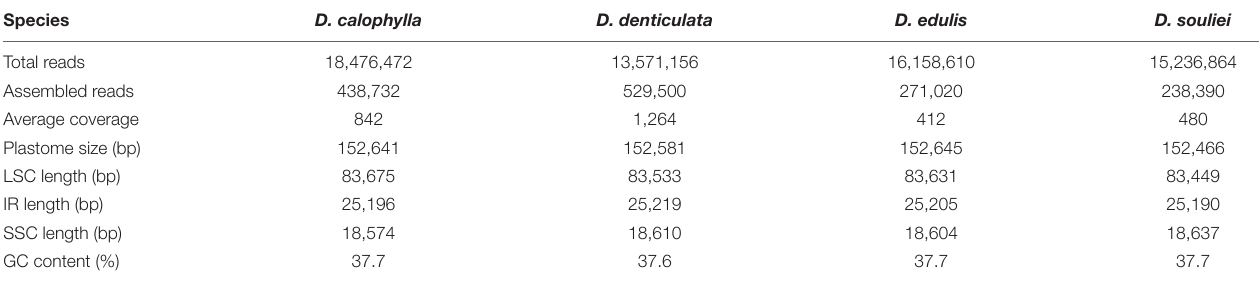
TABLE 1 | Assembly information of newly sequenced plastomes of four Dolomiaea species.